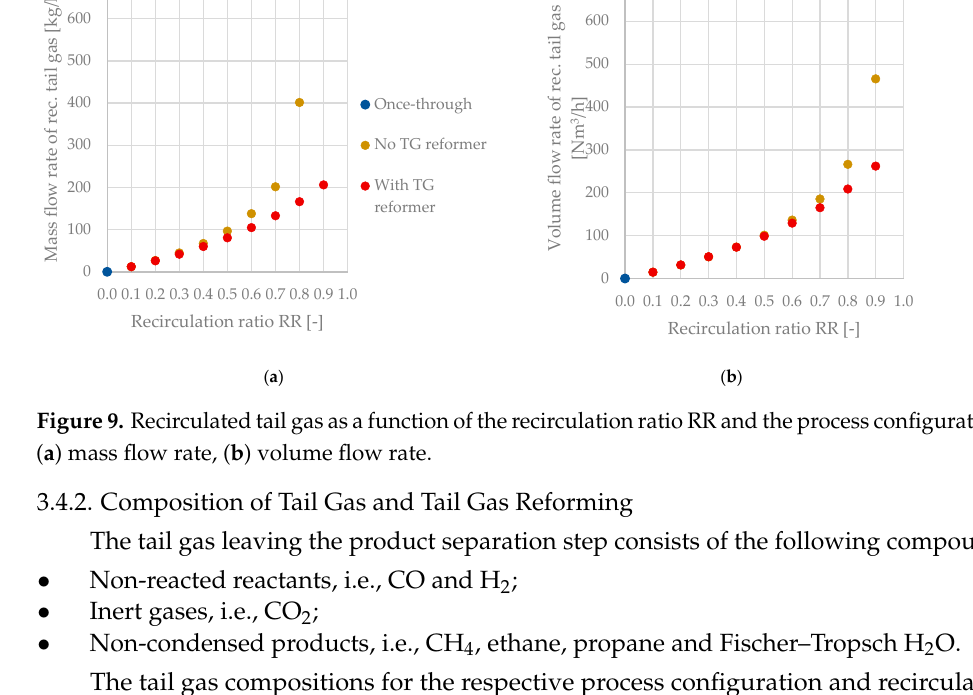
Figure 8. H 2 :CO ratio of the SOEC (co-electrolysis) unit with and without a tail gas reformer.